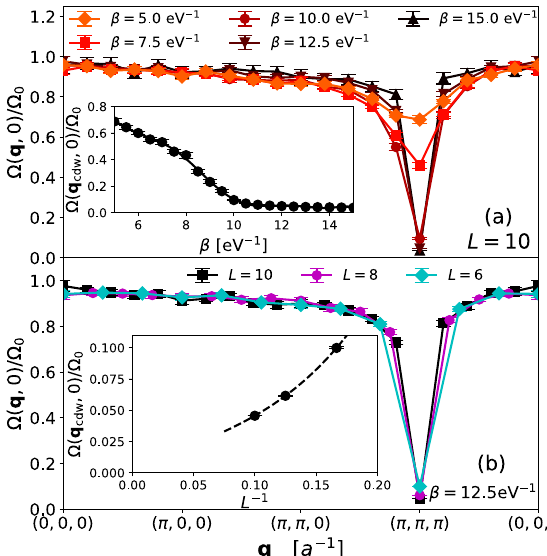
Fig. 5 Sweep through on-site energy difference Δ ϵ = ( ϵ p − ϵ s ). Fig. 4 The renormalized phonon dispersion. a Ω ( q , i ν n = 0) along Results were collected on an L = 4 lattice at inverse temperature the high-symmetry cuts of the fi rst Brillouin zone, computed on an β = 18 eV − 1 . The vertical dashed lines indicate the ab initio value of L = 10 lattice. As the temperature is lowered Ω ( q , i ν n = 0) softens at Δ ϵ . a The total hole density on the O 2 p the ordering wave-vector q = ( π , π , π ) a − 1 , with other q remaining σ orbitals (cyan) and the Bi 6 s orbitals versus Δ ϵ . Near Δ ϵ ≈ − 1.7 eV, these two hole densities are essentially pinned at Ω 0 . The inset shows the softening of the fi cally versus β . b Ω ( q , i ν = 0) for different Ω ( q commensurate. b The structure factor S 6s − 6s ( q cdw ) monotonically n cdw , 0) mode speci increases with Δ ϵ . c The renormalized phonon energy of the lattice sizes, measured at a fi xed inverse temperature β = 12.5 eV − 1 Δ ϵ ≈ − 1.7 eV. The black Ω ( q below the transition temperature. Here, Ω ( q , 0) softens at q cdw for all cdw , 0) mode has a local minimum near line is a guide for the eye. The error bars in this fi gure are the lattice sizes L = 6, 8, and 10. The inset shows Ω ( q cdw , 0) decreasing standard deviation of the mean of our with increasing lattice size, with the dashed line acting as a guide for the eye. The error bars in this fi gure are the standard deviation of the mean of our measurements.